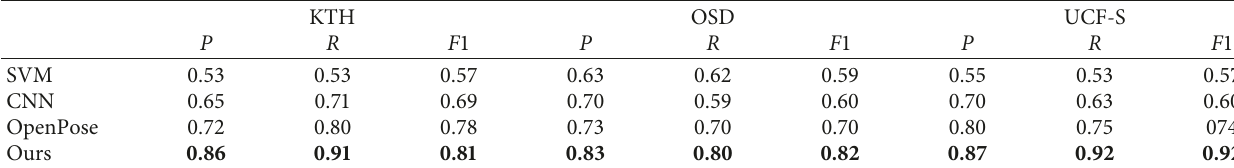
Table 2: Comparison of the accuracy of different methods of identification.